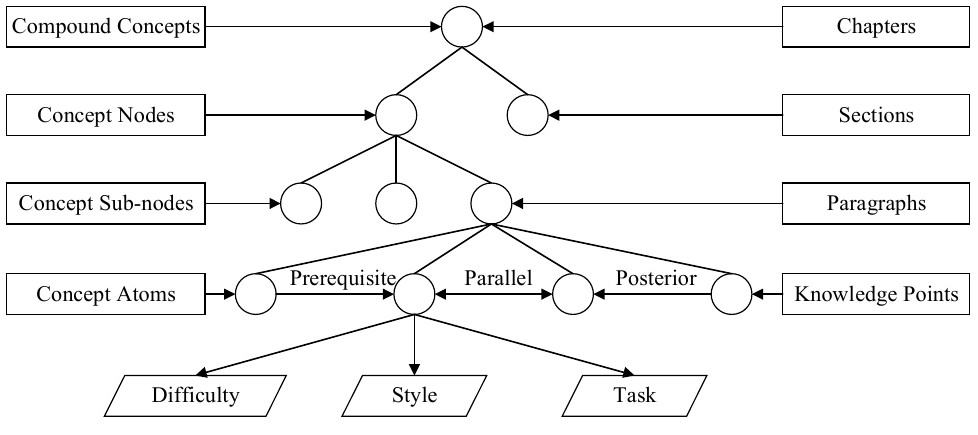
Figure 7. Knowledge sub-model.